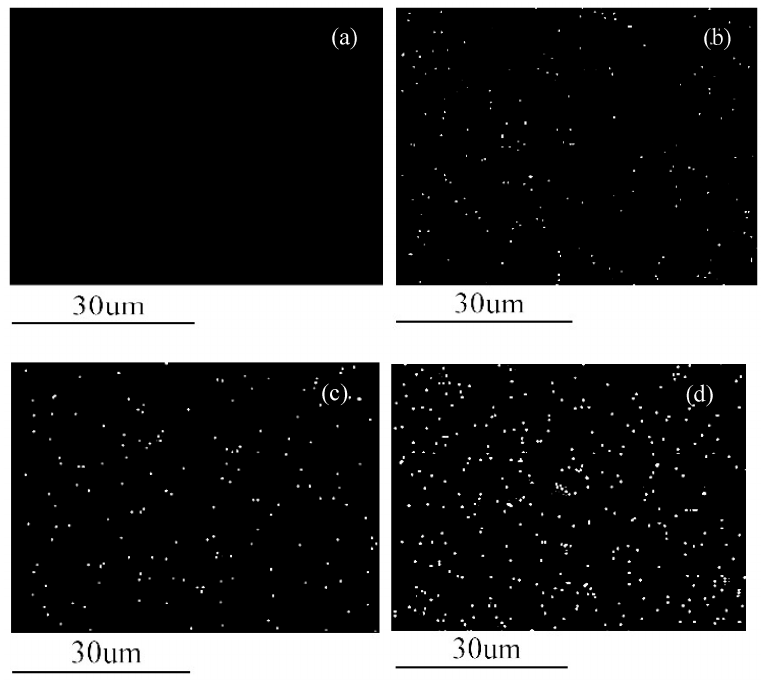
Figure 6. EDX images of Ag distribution in the PLA/MWCNT-Ag nanocomposites: ( a ) PLA; ( b ) PLA/MWCNT-Ag 0.1 ; ( c ) PLA/MWCNT-Ag 0.2 ; and ( d ) PLA/MWCNT-Ag 0.3 .